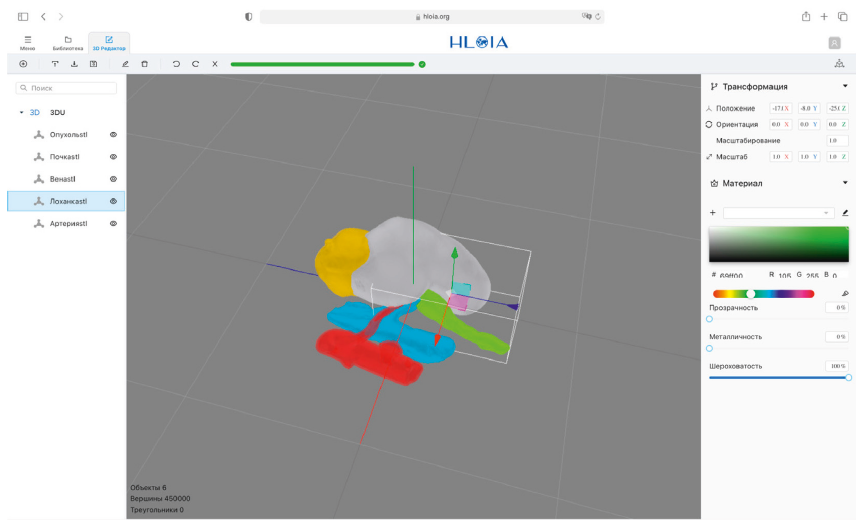
Figure 2: HLOIA’s web application 3D editor